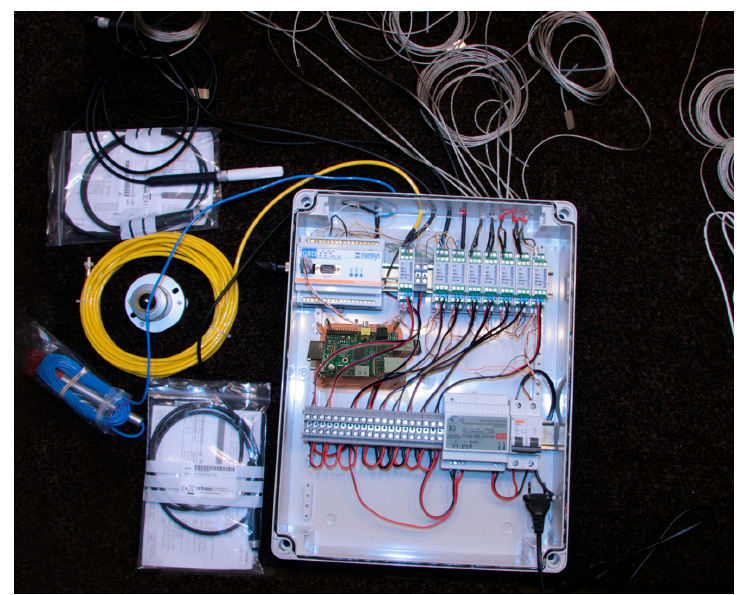
Figure 23. Image of the assembly of the system, with the Data Logger, the Raspberry Pi Processor and the GPRS Communication.